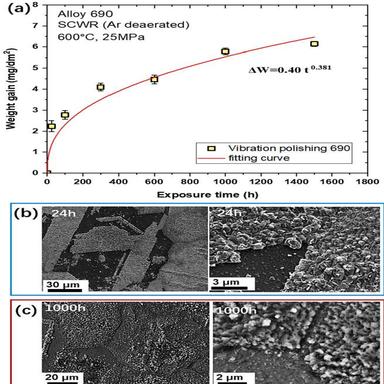
(a) The weight gain curve, and SEM images of the surface oxides formed on alloy 690 in Ar deaerated SCW for (b) 24 h, and (c) 1000 h.